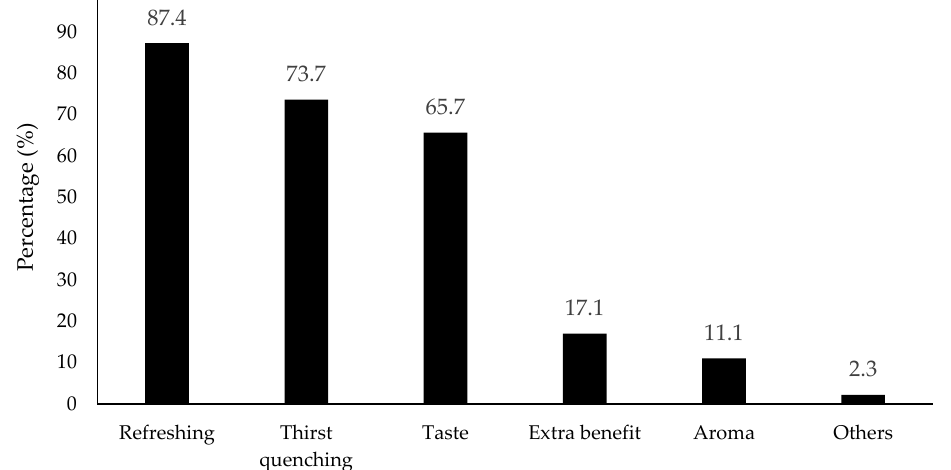
Figure 2. Percentage (%) for the effects that consumers expected the most from the flavored wa- ter/beverage ( n = 901). Others included health, low calories, headache relieve, body hydration, and electrolytes according to the collected data.